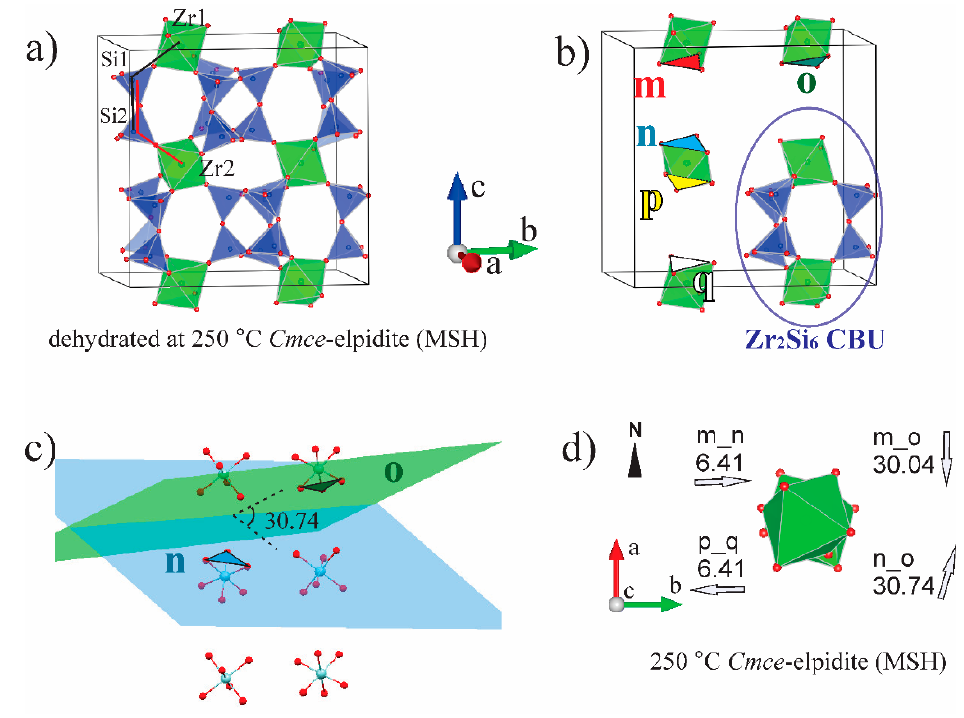
Figure 1. Geometric parameters, characterizing the spatial orientation of adjacent zirconium octahedra in the structure of elpidite materials. ( a ) triads of atoms defining planes allowing the measurement of the twist angles ; ( b ) designation of faces of adjacent zirconium octahedral; ( c ) planes defined by these faces and named with the same letters; ( d ) arrows marking the direction of the dip angles between the correspondingly designated planes measured as azimuth with respect to north (black triangle).